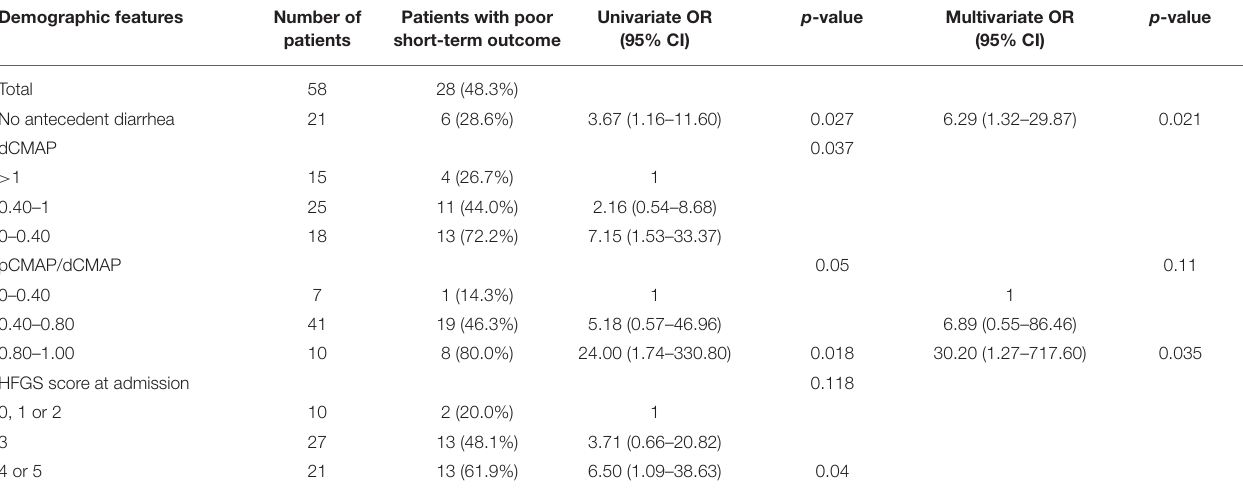
TABLE 3 | Univariate and multivariate regression analyses of the risk of poor short-term outcome in the AMAN subtype patients. Demographic features Number of